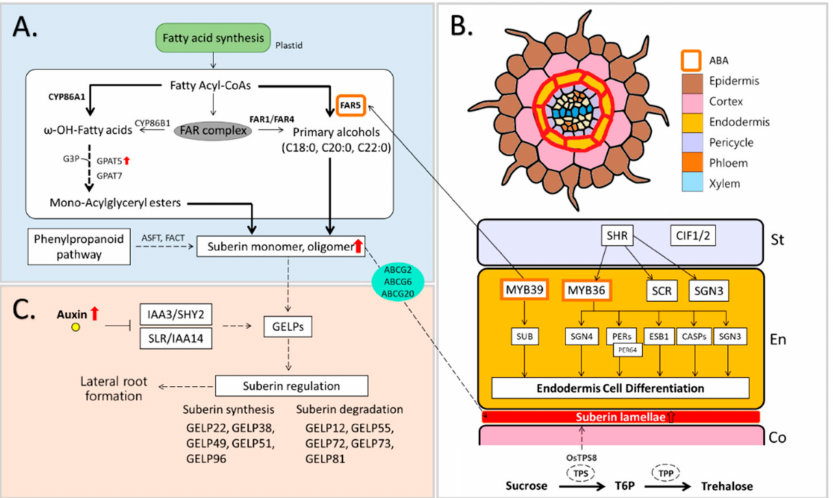
Figure 3. Suberin-related metabolism in drought-associated roots. ( A ) Suberin biosynthesis [95] ( B ) Interaction between Casparian strip-related genes for the formation of suberin lamellae [9,97,108]; ( C ) synthesis and degradation of suberin by auxin-mediated GELPs [105]. ABCG, ATP-binding